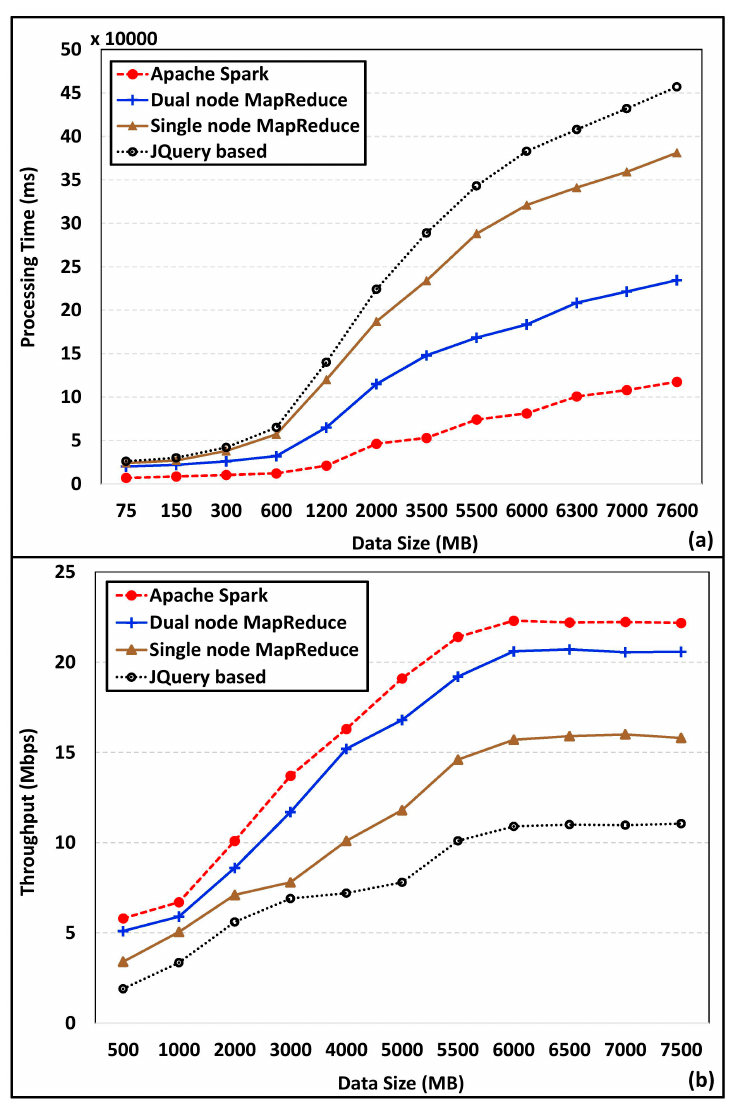
Figure 11. Performance comparison of Spark and MapReduce on dual-node Hadoop. ( a ) Processing time, ( b ) Throughput.